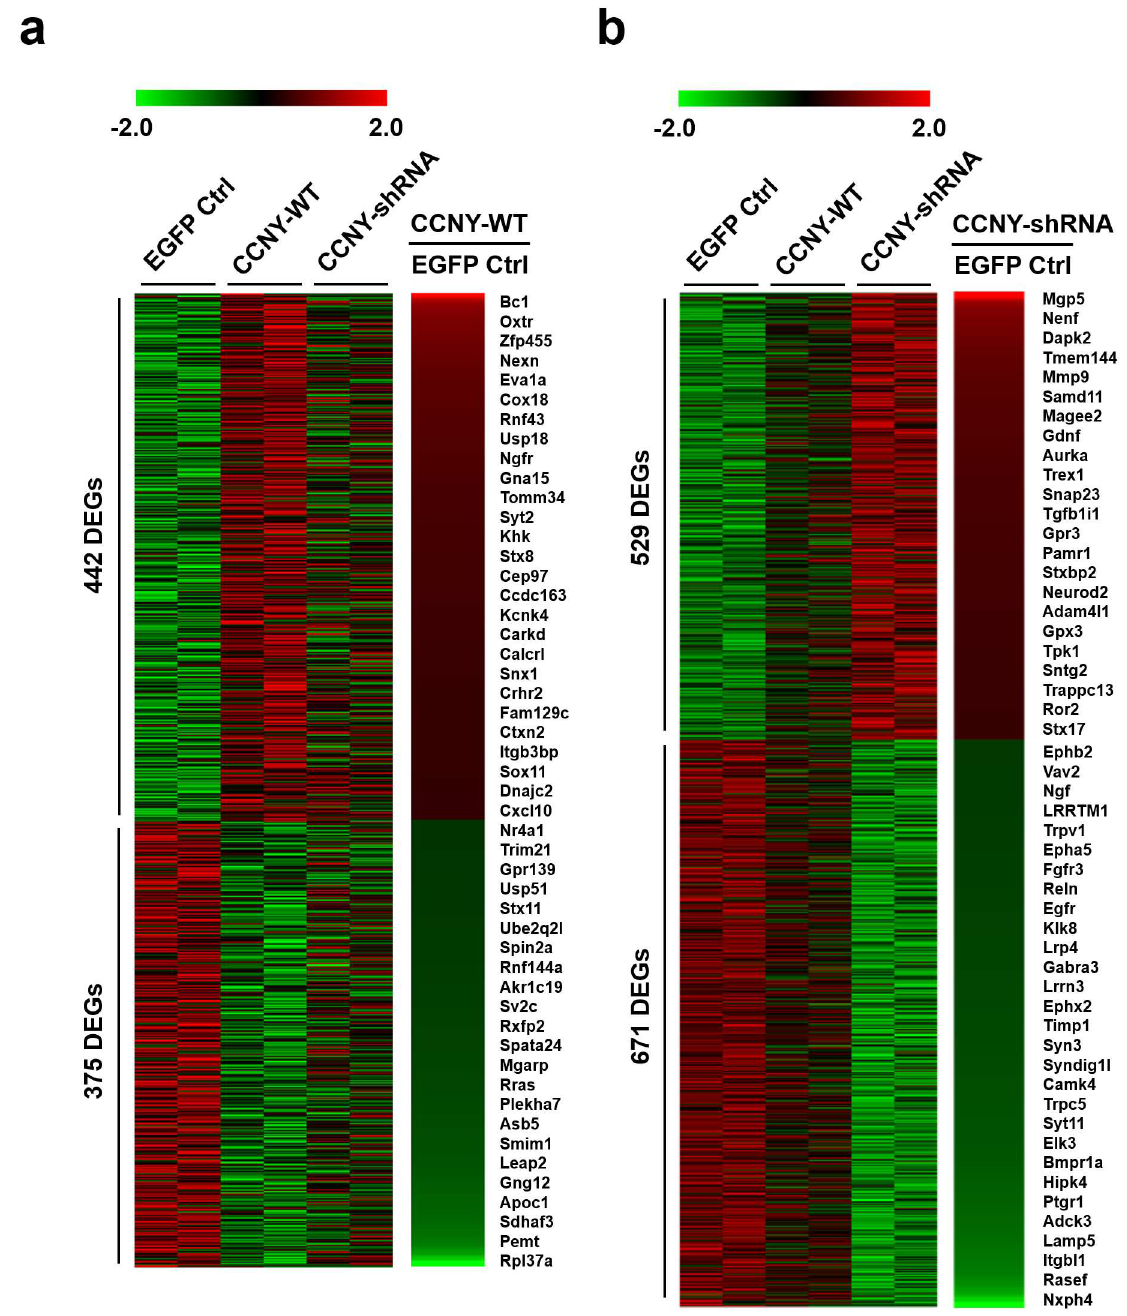
Fig 2. Up- and down-regulated genes by CCNY in the hippocampal neurons. ( a , b ) Heatmaps of differentiallyexpressed genes (DEGs) for up- or down-regulatedgenesby CCNY overexpression ( a ) or knockdown ( b ). Selectedgene names are listed on the right side of the heatmaps. Red indicatesup-regulated gene expressionlevel, whereasgreen indicatesdown-regulated gene expressionlevel. The values of log 2 FPKM were normalized to the value ranges from minimum-2.0 to maximum +2.0.